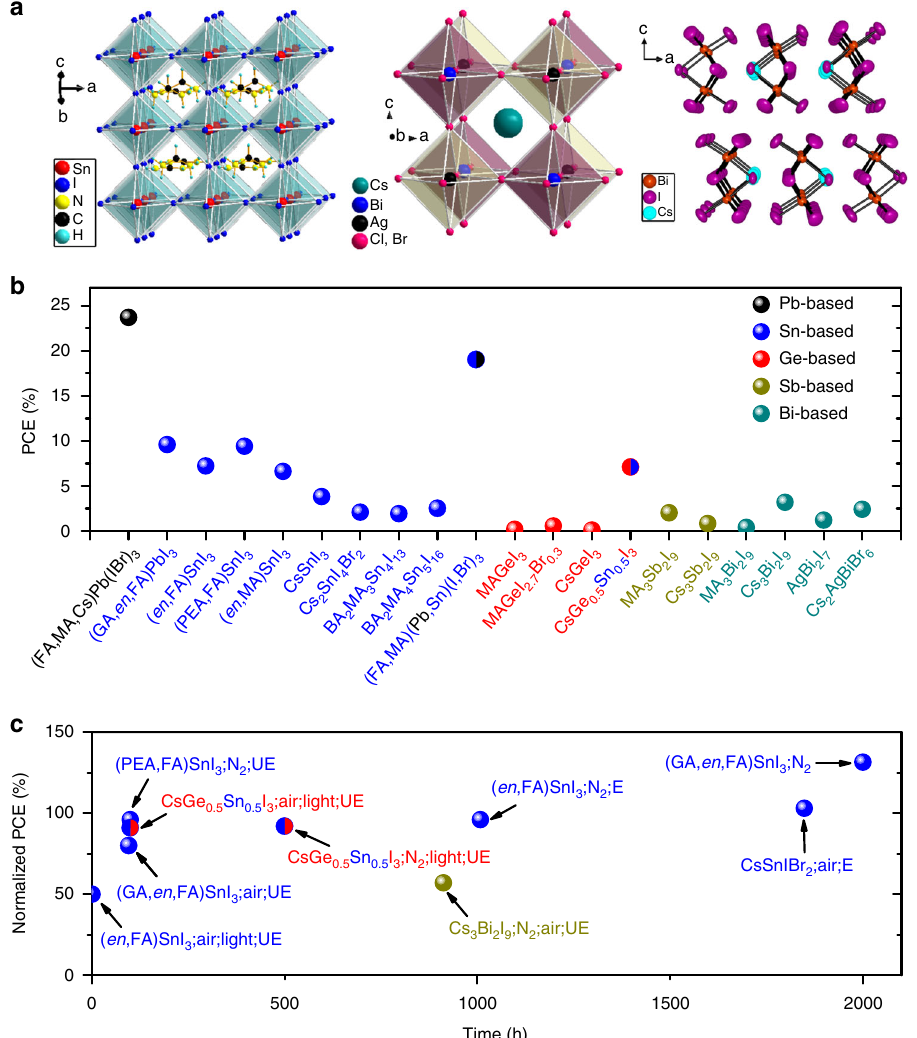
Fig. 2 Comparison of structure, ef fi ciency, and stability of different materials and devices. a Crystals structures of FASnI 3 (left), Cs 2 AgBi(ClBr) 6 (middle), and Cs 3 Bi 2 I 9 (right) 19 . b Record ef fi ciencies of representative solar cells using Pb, Sn, Ge, Sb, and Bi-based absorbers 6,9,13,18 . c Stability of representative Sn, Ge, and Bi-based perovskite solar cells under different conditions, i.e., encapsulated (E), unencapsulated (UE), ambient air, glovebox (N 2 ), and light soaking